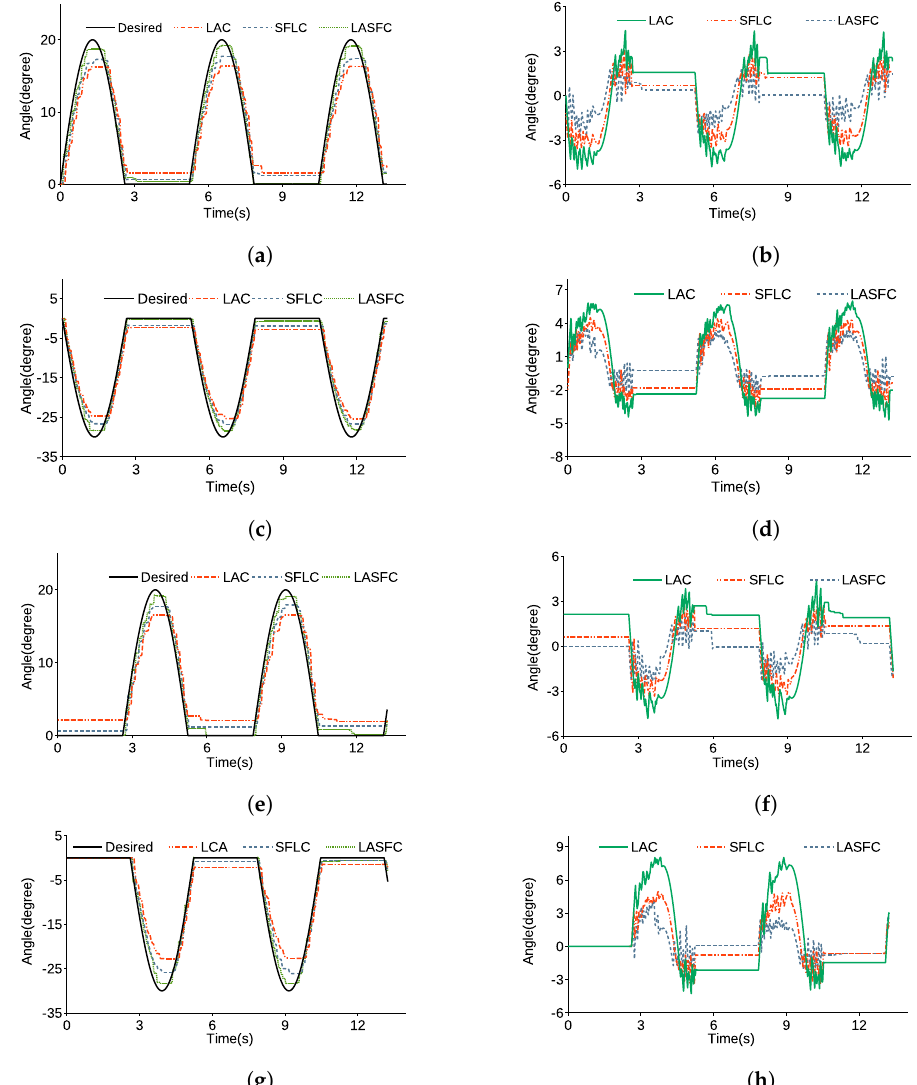
Figure 6. Angular trajectories and error comparison of LAC, SFLC, and LASFC for left hip, left knee, right hip, and right knee: ( a ) left hip, ( b ) left hip error, ( c ) left knee, ( d ) left knee error, ( e ) right hip, ( f ) right hip error, ( g ) right knee, ( h ) right knee